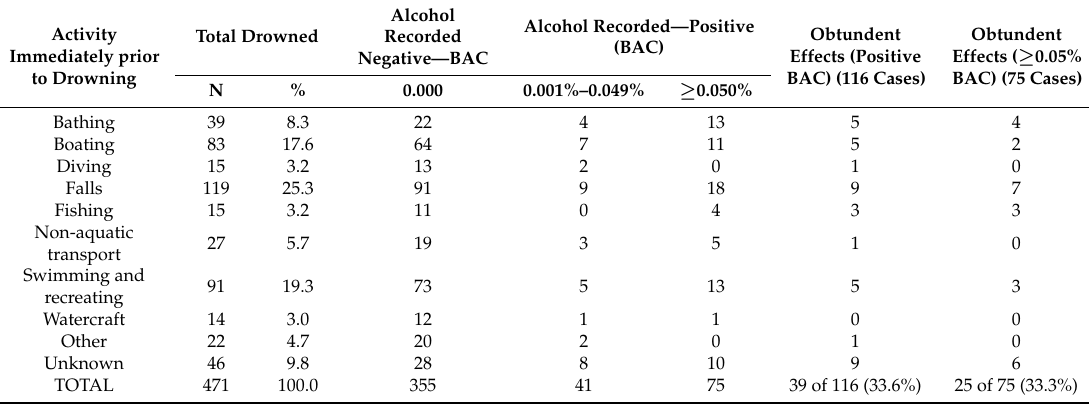
Table 3. Closed coronial cases by involvement of alcohol and presence of obtundent drugs among drowning fatalities in Australia, by activity being undertaken immediately prior to drowning, 2002/03 to 2016/17 with toxicological information available, in victims aged 65 years and over (N =